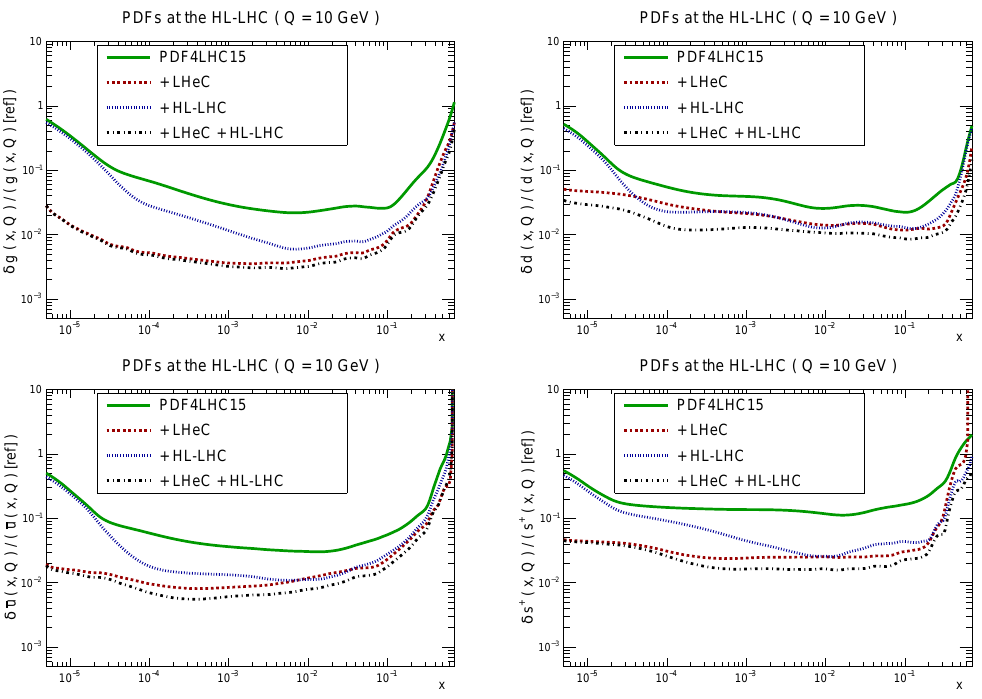
Figure 4.4: Same as Fig. 4.1, now comparing the impact of the LHeC pseudo–data with that of the HL–LHC projections and to their